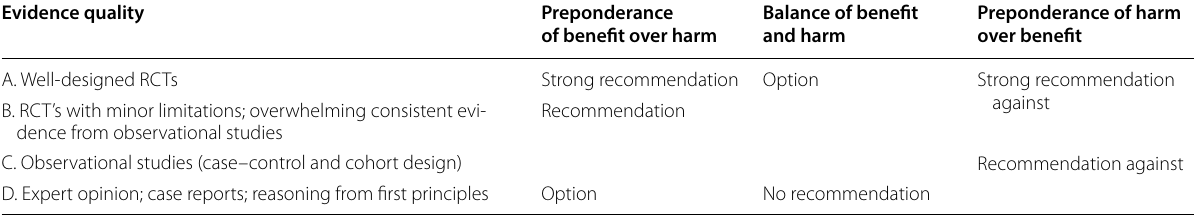
RCT randomized controlled trial